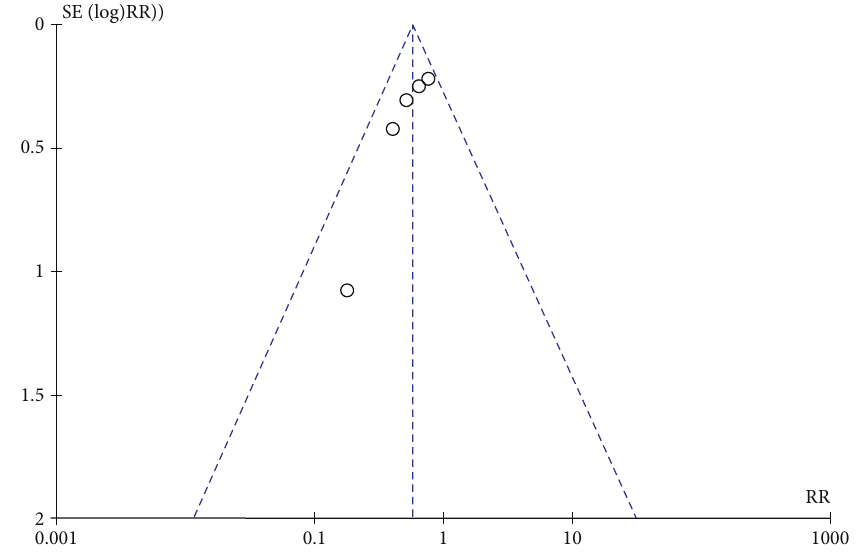
Figure 6: Inverted funnel plot of stricture